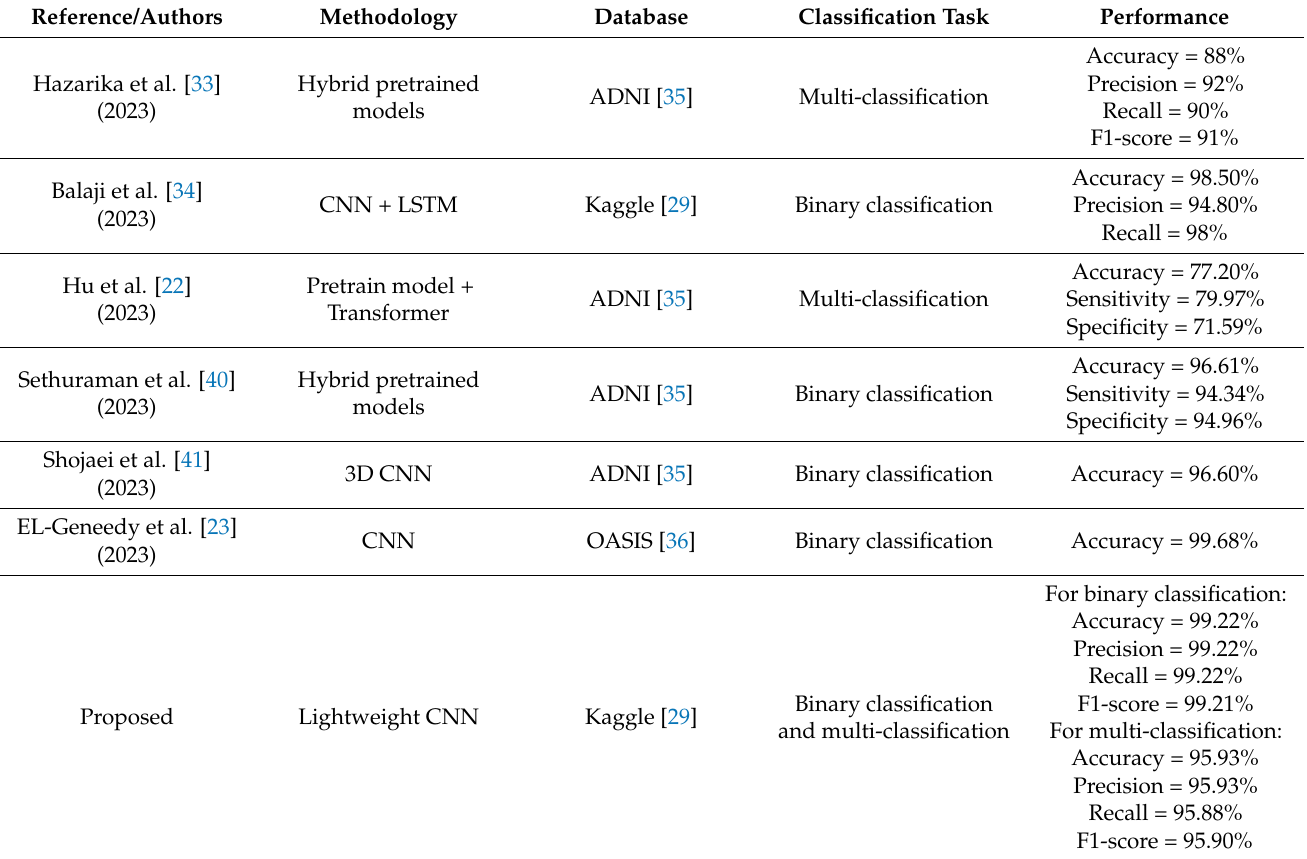
Table 8. Comparison between the proposed model with other recent models on several